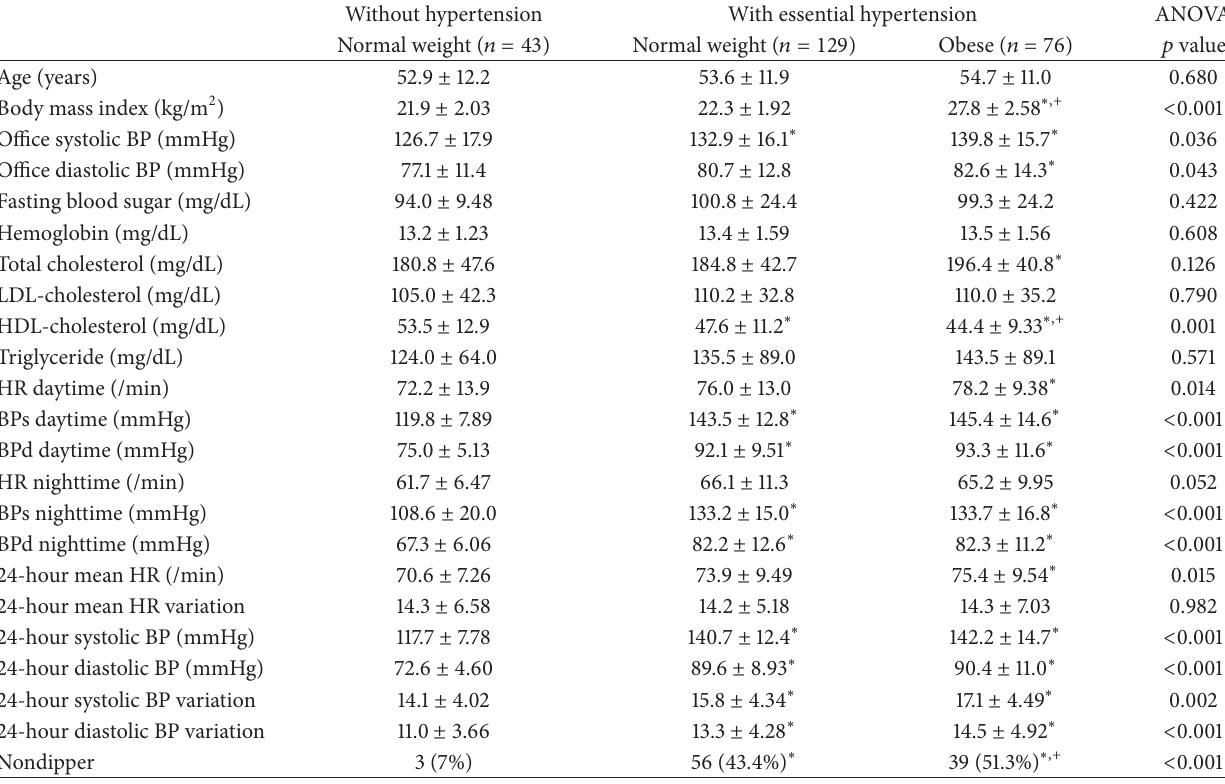
Table 2: The clinical characteristics and ambulatory blood pressure measurements of the study population in females. Without hypertension With essential hypertension